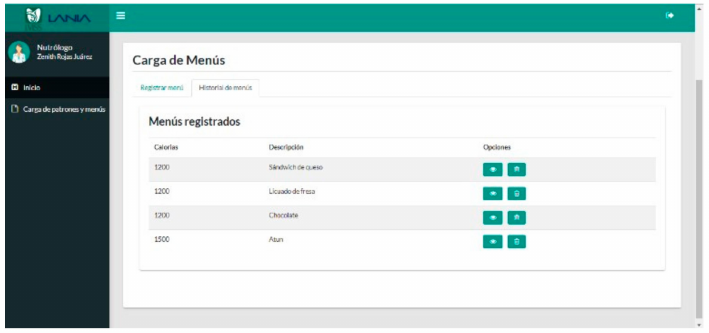
Figure 35. Nutritionist application interface: The history of food